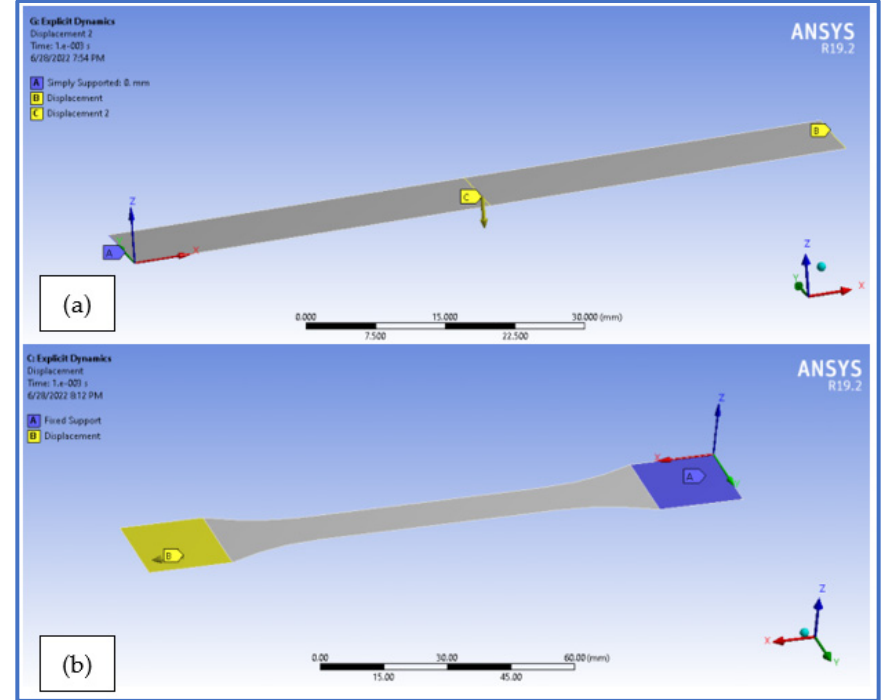
Figure 16. Analysis setup for the finite element specimen models—( a ) bending specimen, ( b ) tensile specimen.